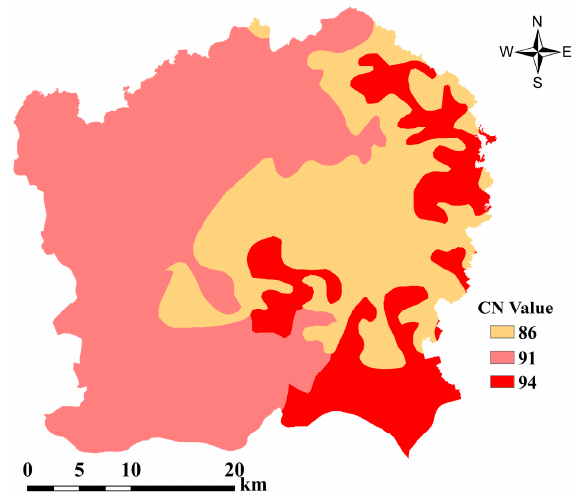
Figure 9. CN map of soil types in this study.